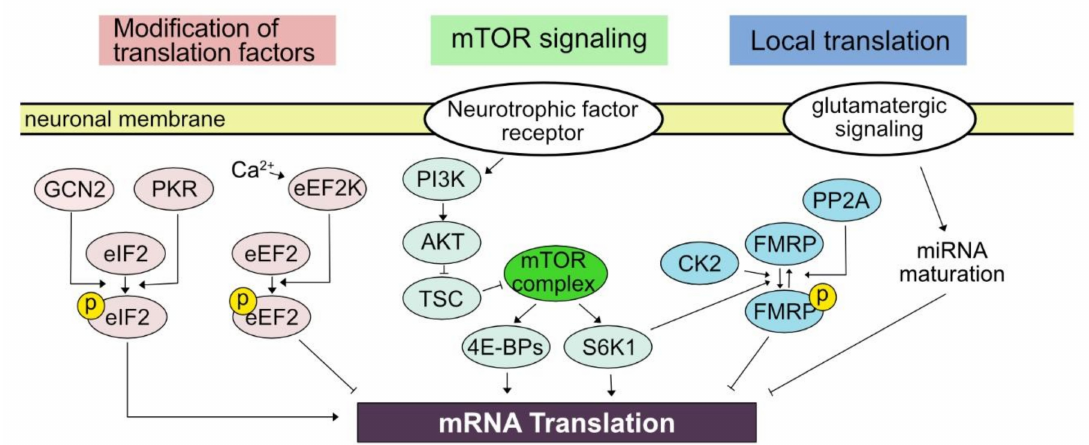
Figure 1. Cellular mechanisms mediating activity-dependent translational control. Intracellular signaling pathways that link neuronal activity to the regulation of mRNA translation can be classified into the modification of translation factors, mTOR signaling pathway, and local translational control. Phosphorylation of eIF2 by GCN2 / PKR and phosphorylation of eEF2 by eEF2K either activates or represses mRNA translation, respectively. mTOR complex is activated by a series of signaling cascade comprised of PI3K-AKT-TSC and a ff ects protein synthesis through 4E-BPs and S6K1. Local translational regulation involves reversible post-translational modifications of FMRP as well as the maturation of